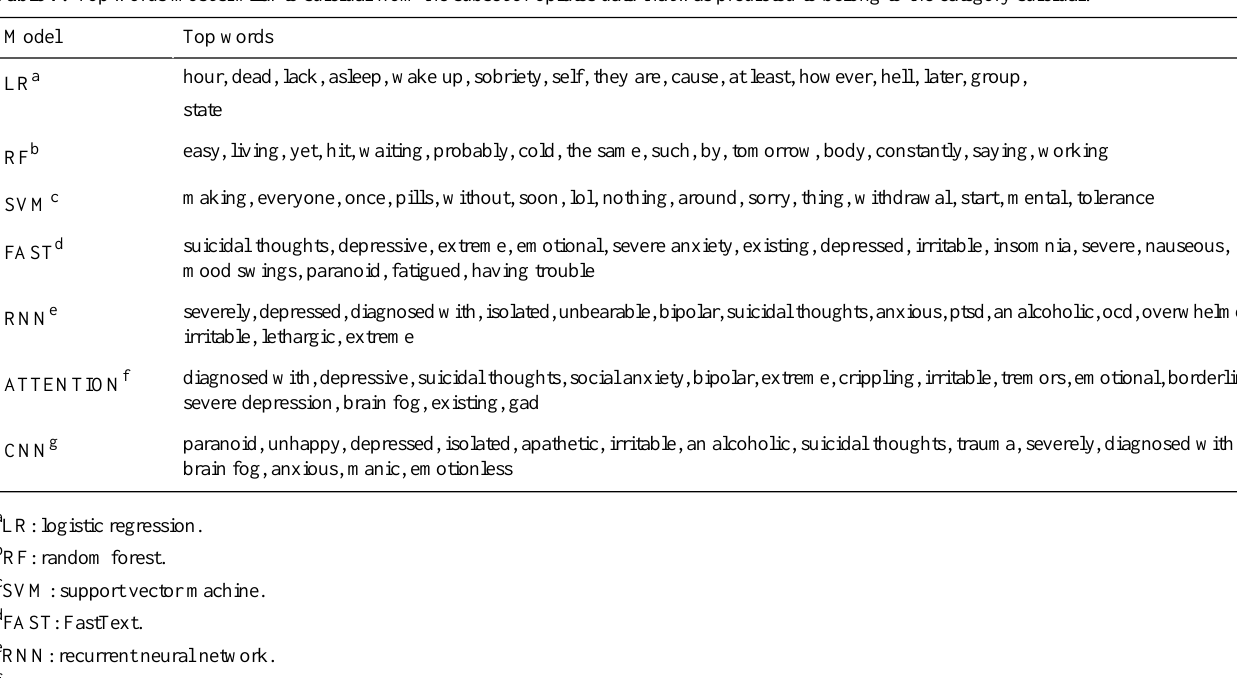
Table 7. Top words most similar to suicidal from the subset of opiates data that was predicted to belong to the category suicidal. Top